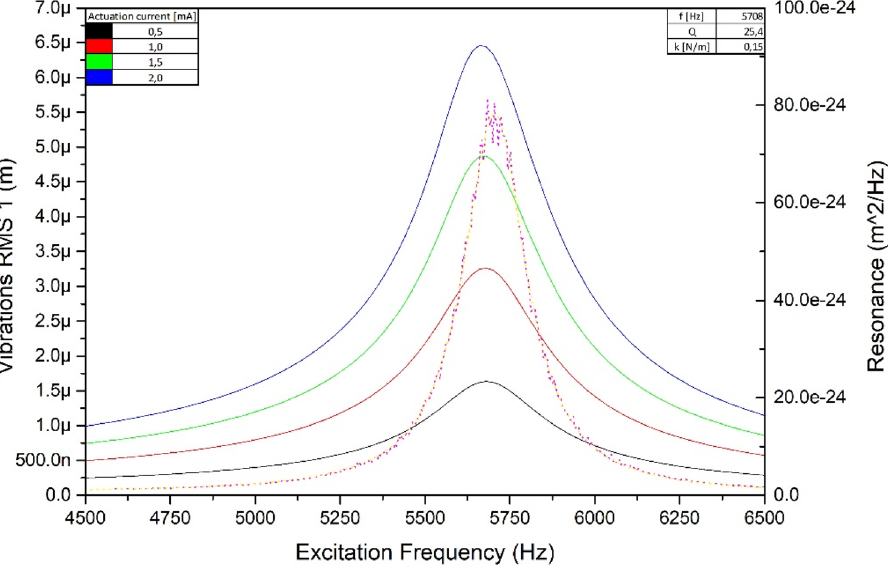
Figure 2. Set of the microcantilever characteristics: actuation curves (continuous lines) for a various actuation currents, the thermomechanical noise characteristics presented as a reference.